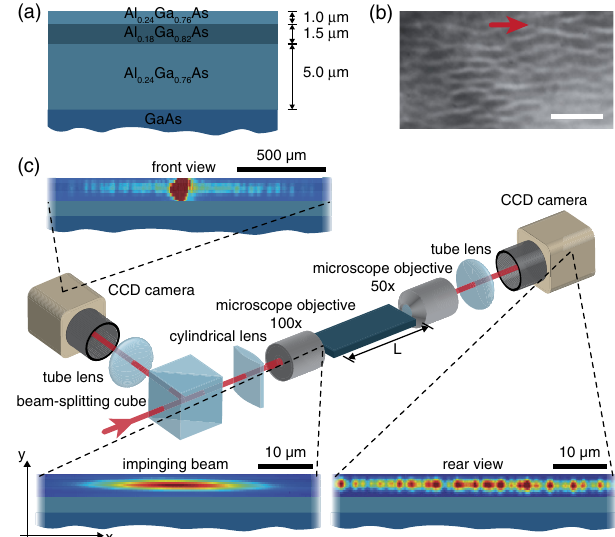
FIG. 1. Experimental setup. (a) Waveguide structures consist- ing of a stacking of Al x Ga x − 1 As layers with varying refractive index (depending on the content x of aluminum). (b) Because of thermal stress during fabrication, ripples form in a preferred direction. The red arrow indicates the main propagation direction of the guided light. Scale bar is 20 μ m. (c) Light is coupled into the waveguide by focusing an elliptically shaped laser beam onto the front facet of the samples (see bottom left-hand inset). A beam splitter is used to monitor the front facet with a CCD camera (see top left-hand inset). Note the differing magnification factor in the horizontal direction due to the cylindrical lens. Besides the backreflected impinging beam, the backscattered light from inside the sample is clearly visible. The intensity distribution at the rear facet is monitored with another CCD camera (see bottom right-hand